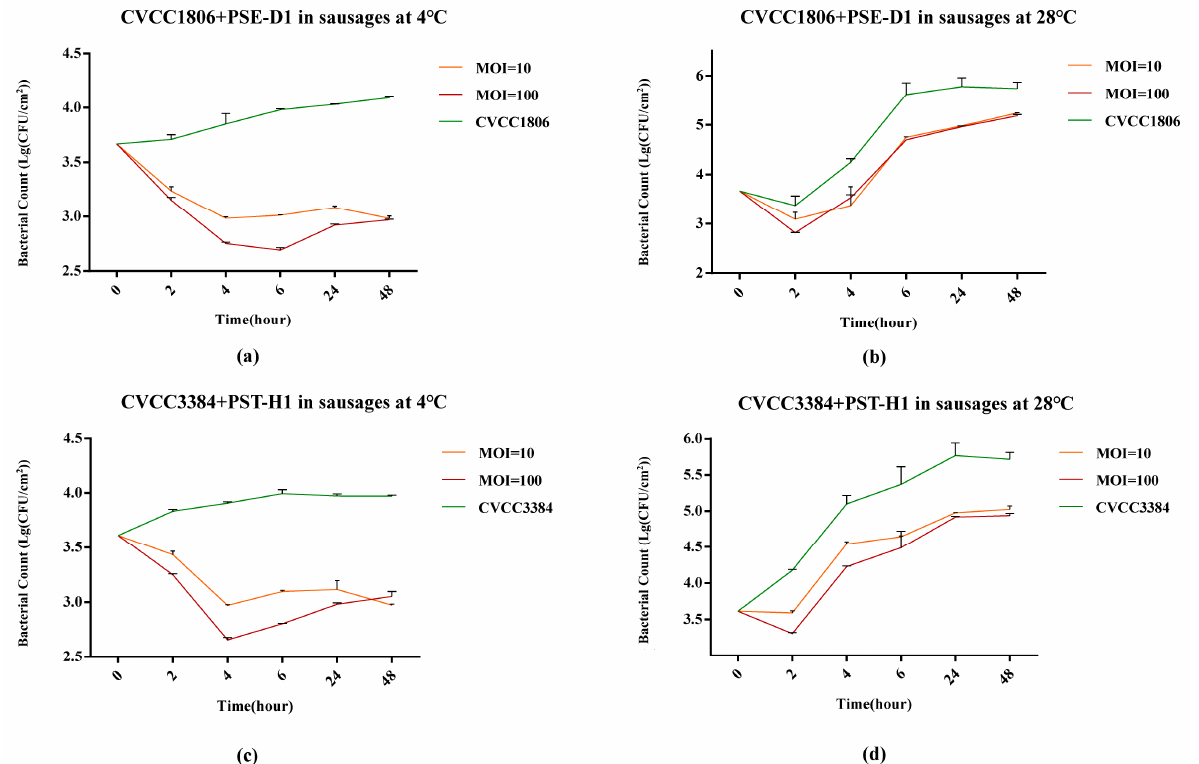
Figure 9. Determination of the antibacterial effect of phages in sausages at different temperatures. ( a ) CVCC1806+PSE-D1 in sausages at 4 °C. ( b ) CVCC1806+PSE-D1 in sausages at 28 °C. ( c ) CVCC3384+PST-H1 in sausages at 4 °C. ( d ) CVCC3384+PST-H1 in sausages at 28 ℃ .